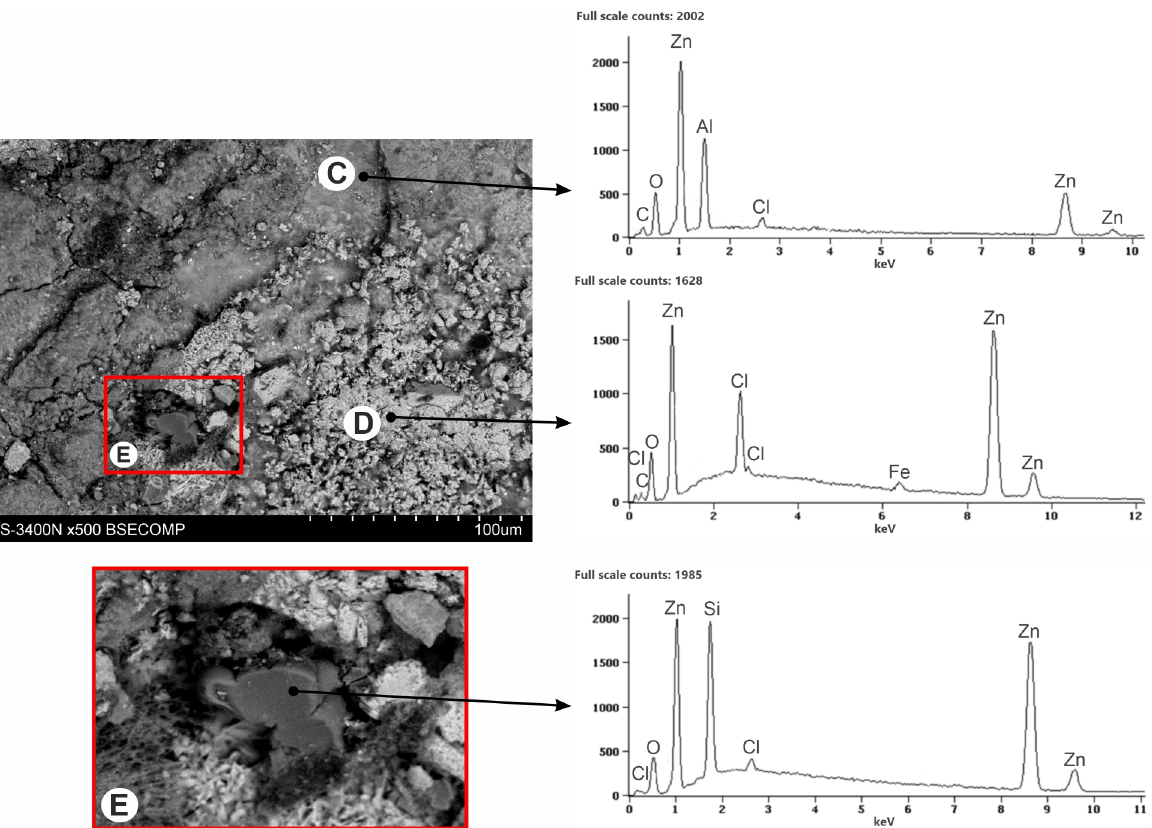
Figure 8. XRD spectra of corrosion products: ( a ) removed from the coating surface and ( b ) the coating surface after removal of white corrosion products.